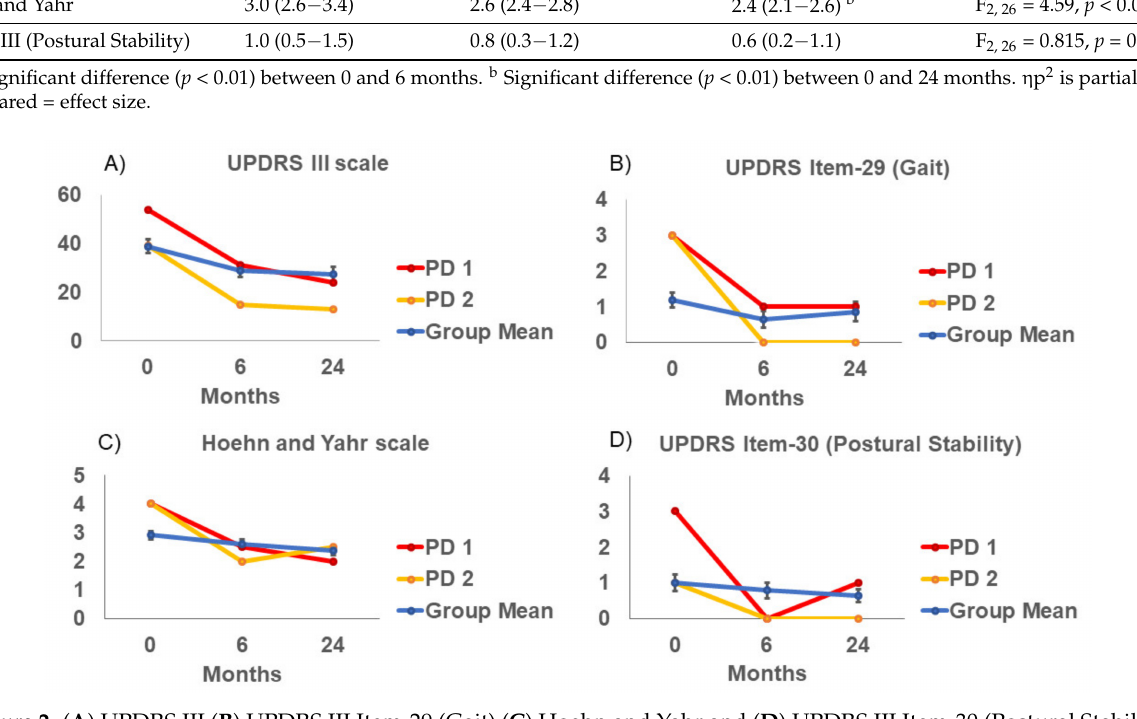
Figure 2. ( A ) UPDRS III ( B ) UPDRS III Item-29 (Gait) ( C ) Hoehn and Yahr and ( D ) UPDRS III Item-30 (Postural Stability) clinical scales at baseline (0 month), 6 and 24 months post-surgery. Group means (SE), and example subjects: Parkinson’s disease (PD) subject 1 (UPDRS = 54), and PD subject 2 (UPDRS =